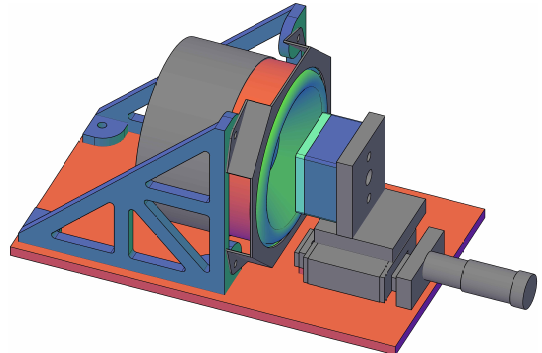
Figure 4. Demonstrator setup using the copper body on the linear stage (right-hand grey part) and loudspeaker (left-hand grey body with the membrane in green) mounted in